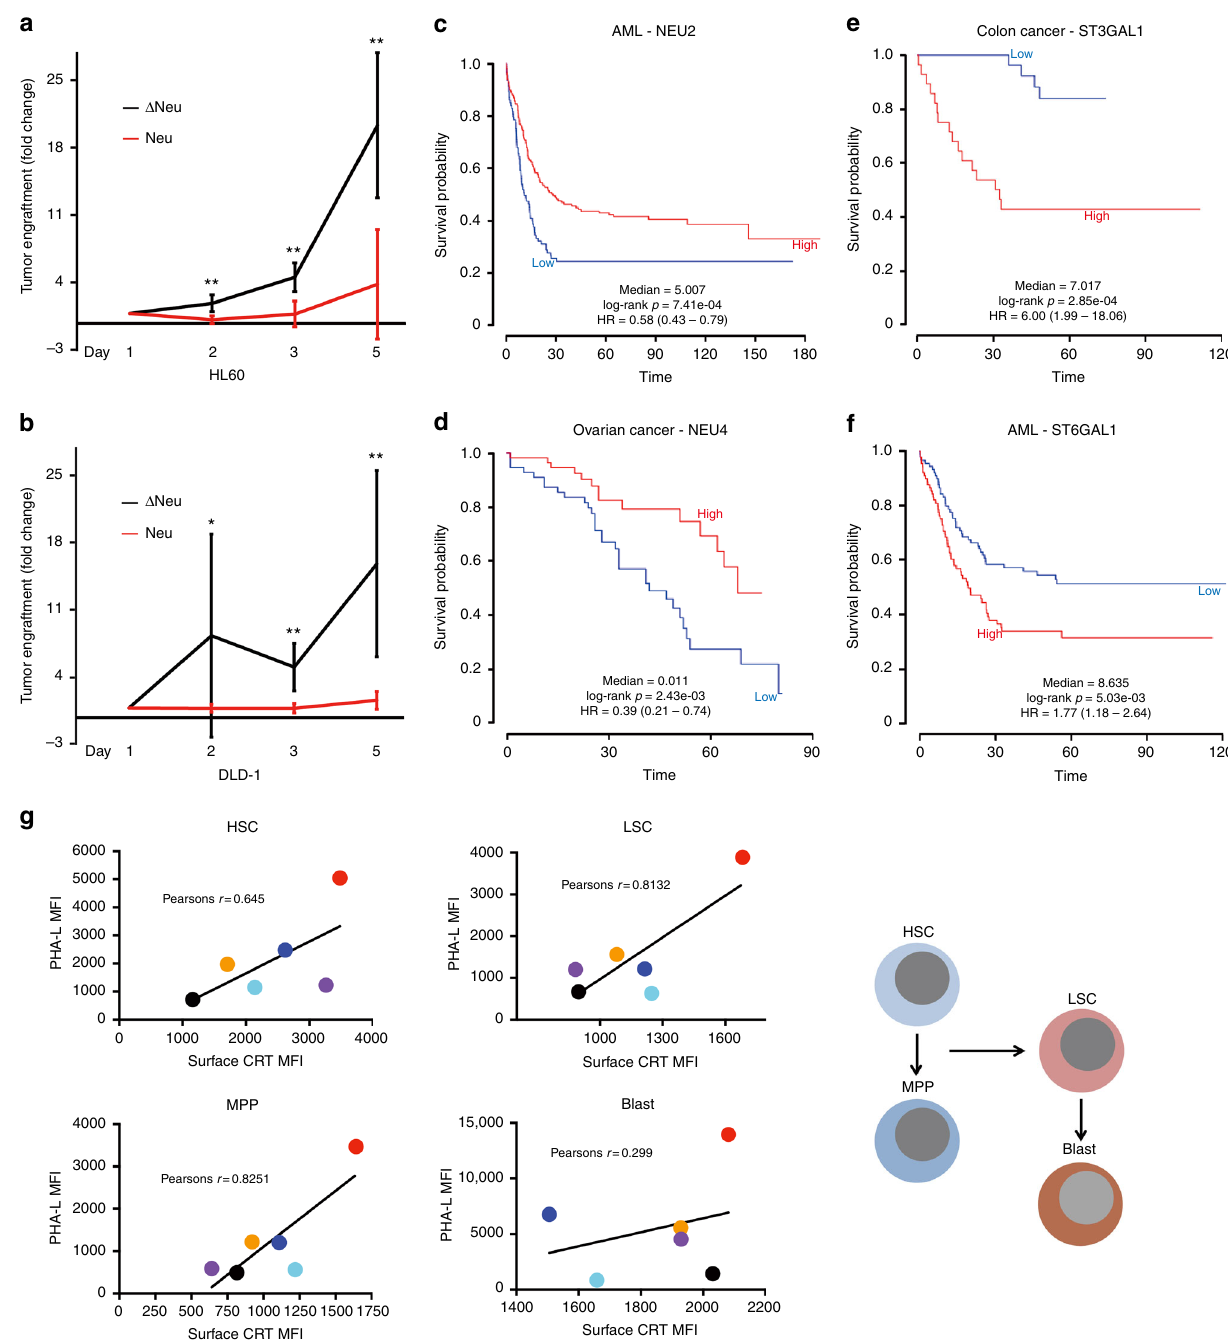
Fig. 6 Function of CRT-binding site in multiple malignancies and hematopoiesis. a , b In vivo tumorigenicity of cancer cells treated with neuraminidase. HL60 and DLD-1 cells were treated with heat inactivated neuraminidase ( Δ neu) or neuraminidase (neu), and injected subcutaneously into NSG mice. Growth of transplanted tumors was monitored by bioluminescence imaging. Tumor growth was normalized to bioluminescence signals of the injection day as fold changes. n = 5. * P < 0.05, ** P < 0.01 ( t -test) for tumor growth between heat inactivated neuraminidase ( Δ neu)- and neuraminidase (neu)-treated groups. Error bars represent standard deviation. c – f Genes related to the regulation of CRT-binding sites as a diagnostic marker for overall survival of cancer patients. Higher expression of NEU2 and NEU4 which induce the removal of sialic acids correlated with an improved survival while higher expression of ST3GAL1 and ST6GAL1 which enhance sialic acid expression correlated with a worse outcome. g Correlation between PHA-L binding and CRT levels on the cell surface of hematopoietic stem cells (HSC), Multipotential progenitor (MPP), leukemia stem cells (LSC), and blasts cells from primary AML patient samples; analysis by fl ow cytometry. In g , MFI, mean fl uorescence